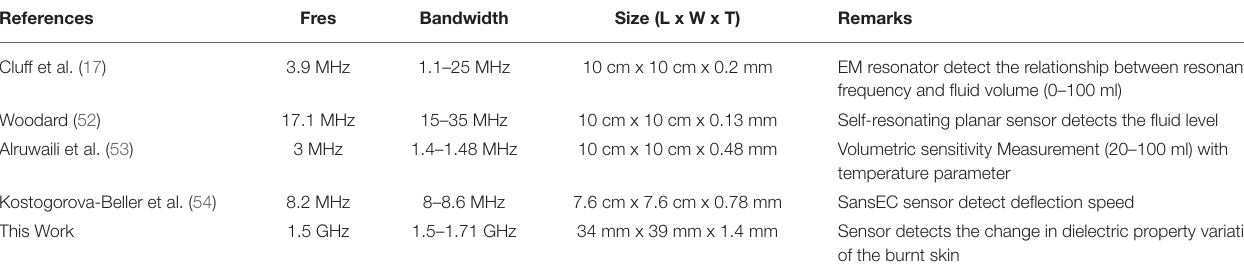
TABLE 2 | Comparison of the proposed sensor performance with previously published